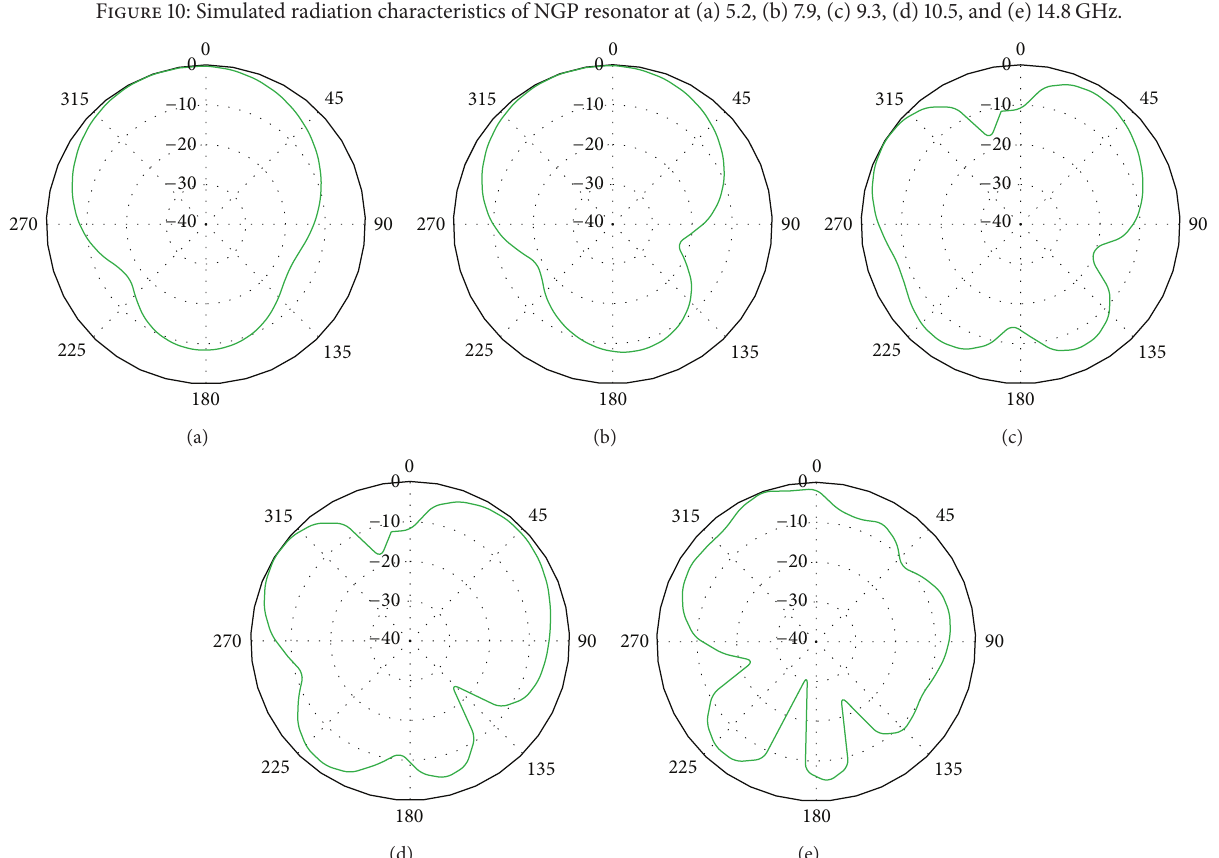
Figure 11: Simulated radiation characteristics of DGS resonator at (a) 5.11, (b) 7.7, (c) 8.7, (d) 11, and (e) 14.3